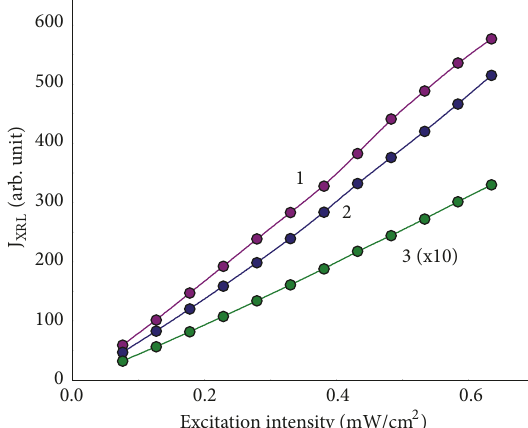
Figure 7: Dose dependencies of the phosphorescence intensity 𝐽 Ph of the ZnSe sample (𝑡 ph = 30 s) at registration within 630 nm band at the temperature of 85 K under different intensities of the X-ray radiation: 𝑖 X = 5 mA (1) and 25 mA (2) . The solid lines show the - tube theoretical dependency